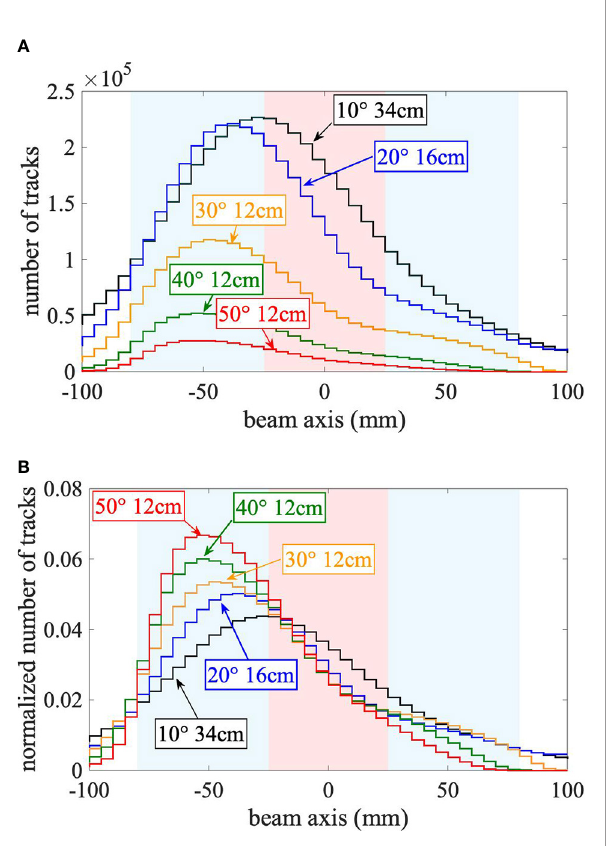
FIGURE 3 | (A) Absolute emission pro fi les. (B) Normalized emission pro fi les. (A) Absolute and (B) normalized (to the integral) secondary-ion emission pro fi les along the beam axis for each studied mini-tracker position without air cavity. The cylindrical head phantom (radius of 80 mm) is centered in the isocenter at a depth along the beam axis of 0 mm and is highlighted by the blue area. The spherical target volume (25 mm radius) is represented by the red area. The beam crosses the head phantom from left to right. The statistical uncertainties are plotted as uncertainty bands.